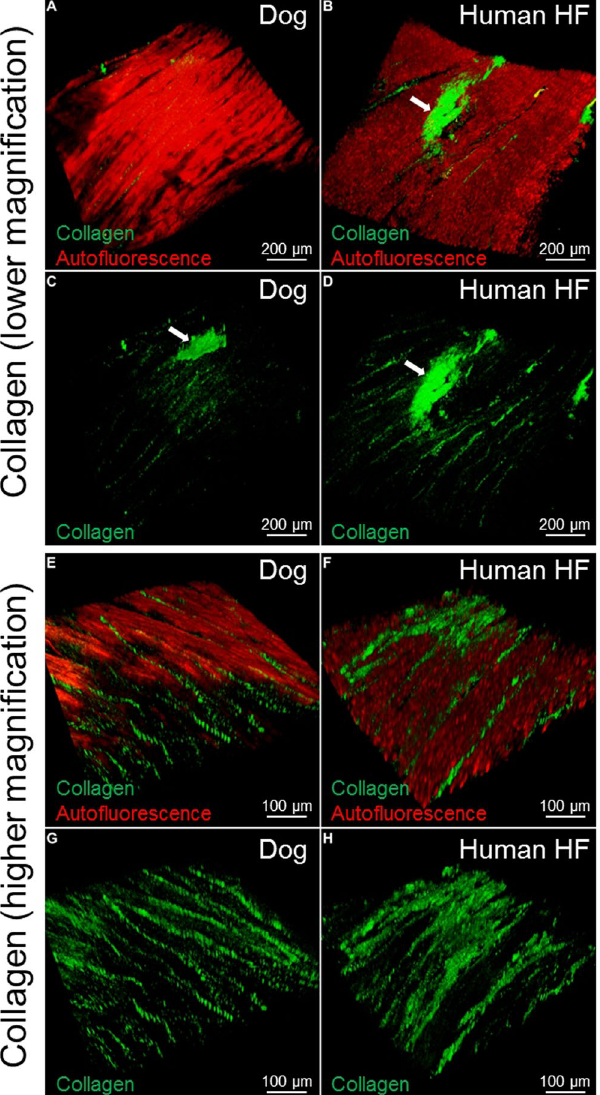
Figure 3. SHG imaging of Collagen type 1 in canine and human myocardial slices. Lower magnification of canine ( A , C ) and human ( B , D ) myocardial tissue. The autofluorescence (red) is used to show the structure of the myocardium; the collagen fibres (green) are located within the cardiac muscle fibres. The white arrows indicate the collagen in proximity to a large vessel. Higher magnification of healthy dog samples ( E , G ): the collagen is organised in strands between the muscle fibres; in human heart failure samples ( F , H ) the regular structure is partially lost and the collagen is less organised. At least 3 slices were used for each